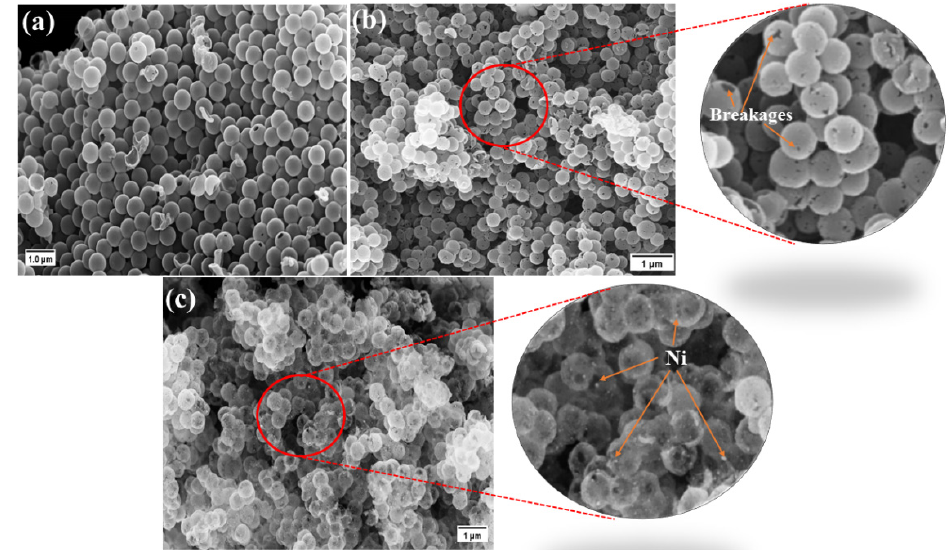
Figure 1: SEM micrographs of ( a ) pristine HCSs; Ni@HCSs samples using ( b ) NiCl 2 , and ( c ) Ni(acet) 2 precursors.